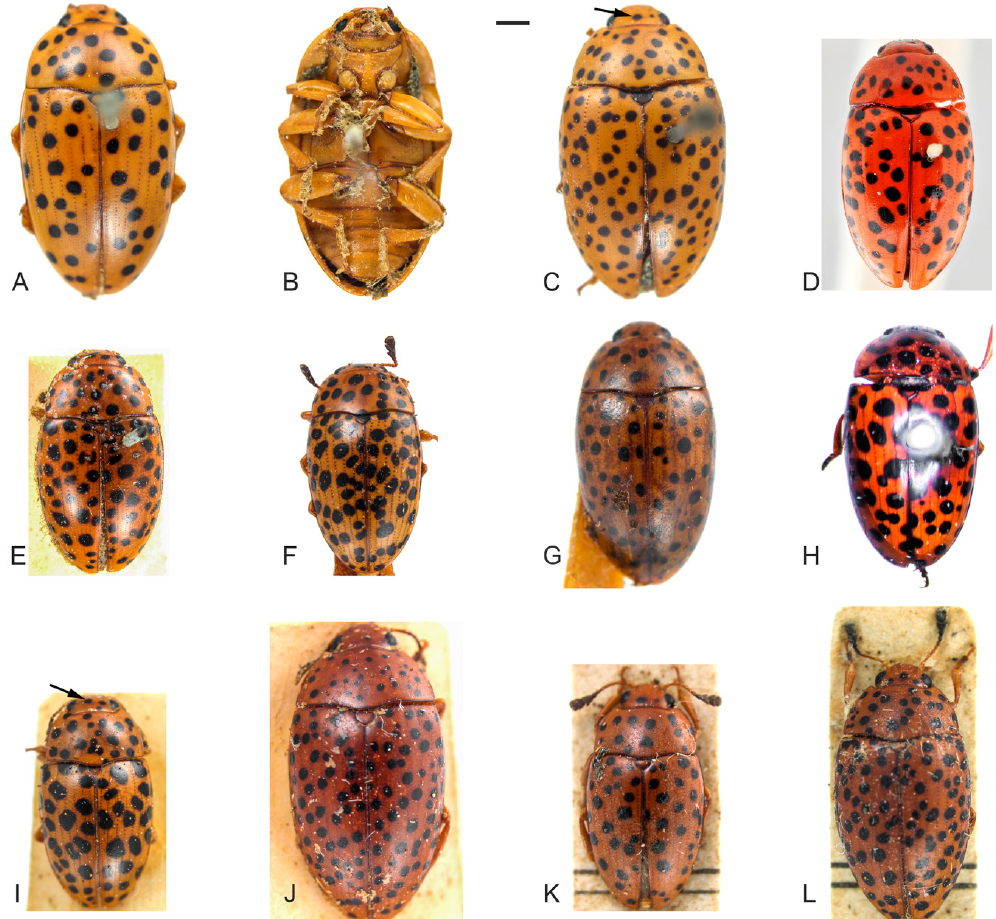
Figure 1. ( A – L ) Specimens of Mycotretus tigrinus Olivier, 1792 from different localities: ( A – B ) male, dorsal and ventral view, respectively (Corupá, Santa Catarina (SC)). ( C – L ) dorsal view: ( C ) female, arrow showing a spot on the head (Corupá, SC); ( D ) a “topotype” deposited in the Royal Belgian Institute of Natural Sciences (RBINS) (Suriname); ( E ) male (Tefé, Amazonas (AM), Brazil); ( F ) male (Linhares, Espírito Santo (ES), Brazil); ( G ) female (Parque Nacional do Xingu, Mato Grosso (MT), Brazil); ( H ) lectotype of M. multimaculatus Taschenberg, 1870 (Colombia); ( I ) male, arrow showing spots on the head (Buena Vista, Bolivia); ( J ) female (Buena Vista, Bolivia); ( K ) male (Chapare, Bolivia); ( L ) female (Chapare, Bolivia). Scale bars: A – G , I – L = 1 mm; H, see Section 2.